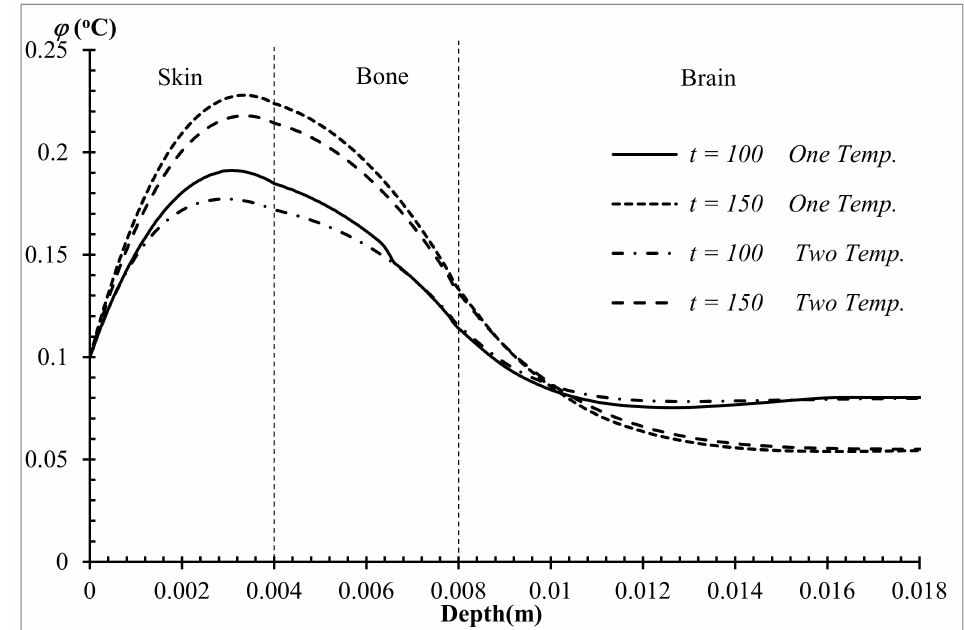
Figure 10. The conductive temperature increment at various times on an adult’s head.